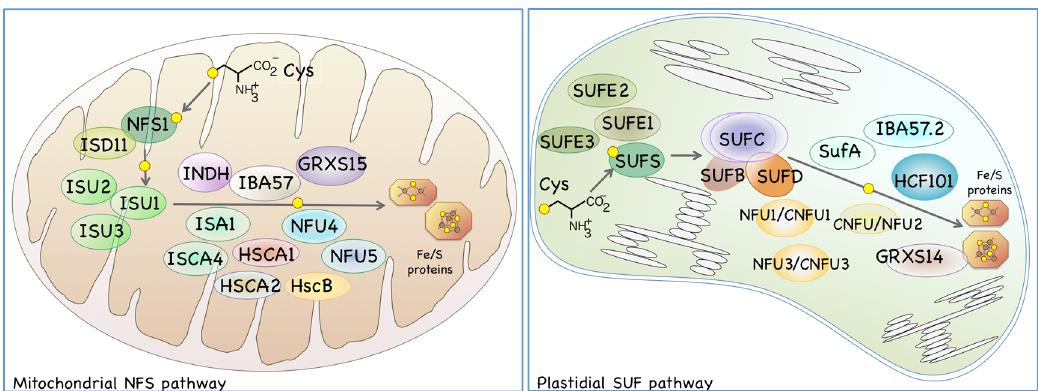
Figure 2. Two distinct Fe/S cluster biosynthetic pathways exist in mitochondria (mitochondrial NFS pathway, left) and plastid (plastidial SUF pathway, right) in Arabidopsis . Sulfur from the L-cysteine (Cys) substrate is assembled into a nascent Fe/S cluster of the scaffold proteins, and then the cluster is transferred through carrier proteins before finally being incorporated into various Fe/S apo-proteins. As examples, the Fe/S proteins of the [2Fe-2S] type and of the [4Fe-4S] type (iron ions and sulfur atoms are indicated as brown and yellow dots, respectively) are shown.